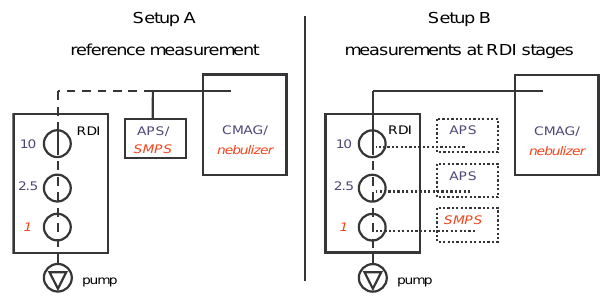
Fig. 2. Schematic layout of the two subsequent setups for cutoff de- termination experiments: the left side illustrates the reference mea- surement (setup A), where the concentration of oil droplets pro- duced by the CMAG is measured directly with the APS. For stage 1 the NaCl concentration produced by a nebulizer is measured with the SMPS. The RDI is connected in order to simulate realistic flow conditions. The right side displays the actual experimental setup, where the APS is connected subsequently to the covers of stages 10 and 2.5 and then the SMPS is connected to the cover of stage 1 (setup